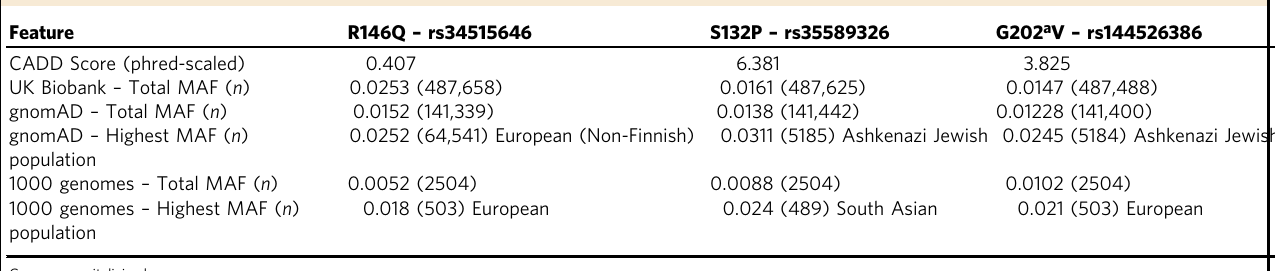
Table 2 Human MLKL brace helix polymorphism frequency human MLKL